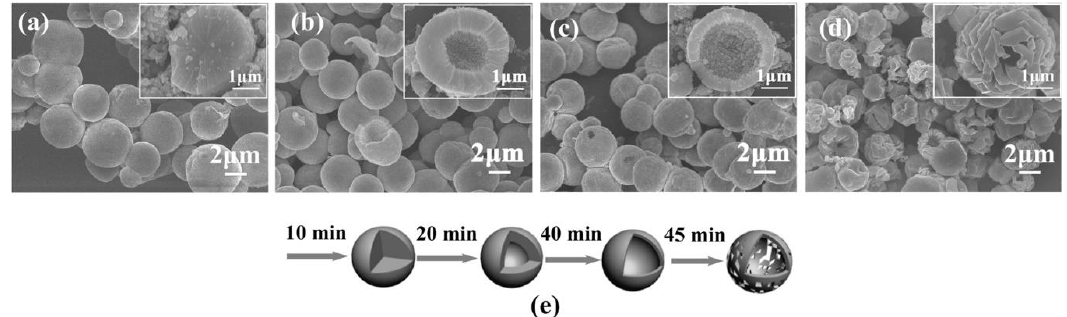
Figure 24. SEM images of morphology evolution of ZnO microspheres prepared with 2 mmol trisodium citrate dihydrate at 90˚C for 70 different microwave irradiation durations: ( a ) 10 min, ( b ) 20 min, ( c ) 40 min, and ( d ) 45 min. ( e ) Schematic illustration of the formation process of a hollow ZnO